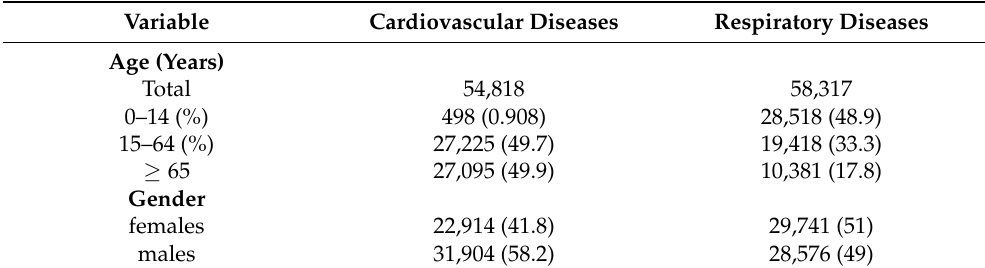
Table 1. Summary statistics of respiratory and cardiovascular diseases hospital admissions in the City of Cape Town by age and sex, from 1 January 2011 to 31 October 2016.